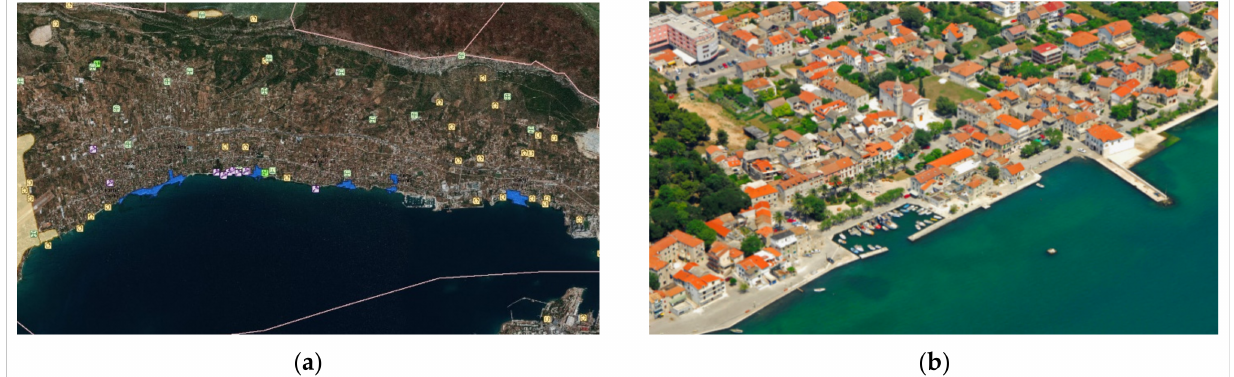
Figure 1. Town of Kaštela: ( a ) protected architectural heritage of the town of Kaštela; ( b ) a view of an old historical core, Kastel Kambelovac [39].